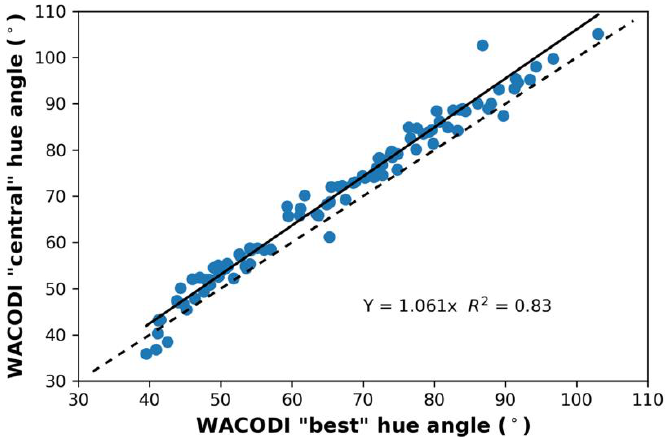
Figure 11. Relation between the hue angle derived from the center and best part of the image. The solid line represents the regression through the data, the dashed line represents the 1:1 relationship.